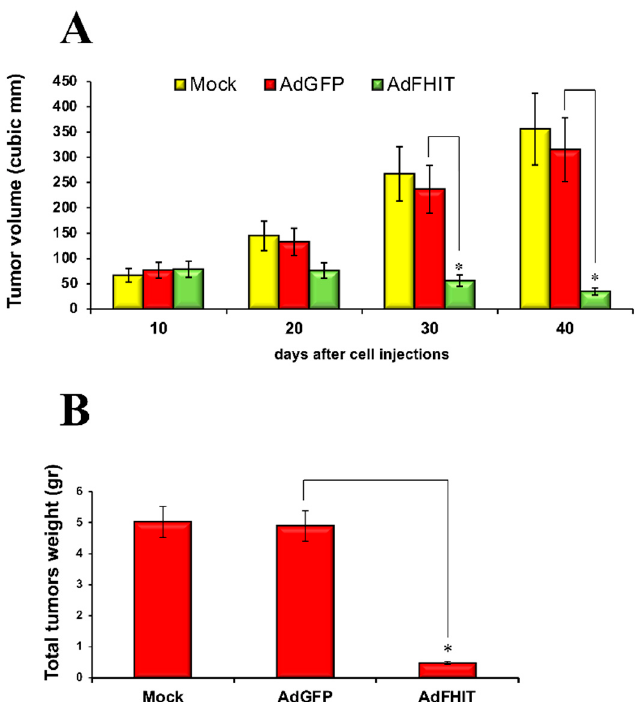
Figure 5. Tumor suppressor activity of Fhit in melanoma xenograft. ( A ) Tumor volumes at 10, 20, 30, and 40 days for the mock, Ad GFP, and Ad FHIT groups of mice (5 mice/group). Overall, 10 × 10 6 Colo38 cells were pre-infected with Ad FHIT or Ad GFP for 12 h and then injected subcutaneously into nude mice (5 mice for the group). Tumors were measured every 10 days, as reported in the graph (Student’s t -test, * p < 0.05). ( B ) Tumors were extracted and weighed after 40 days (Student’s t -test, * p < 0.05).